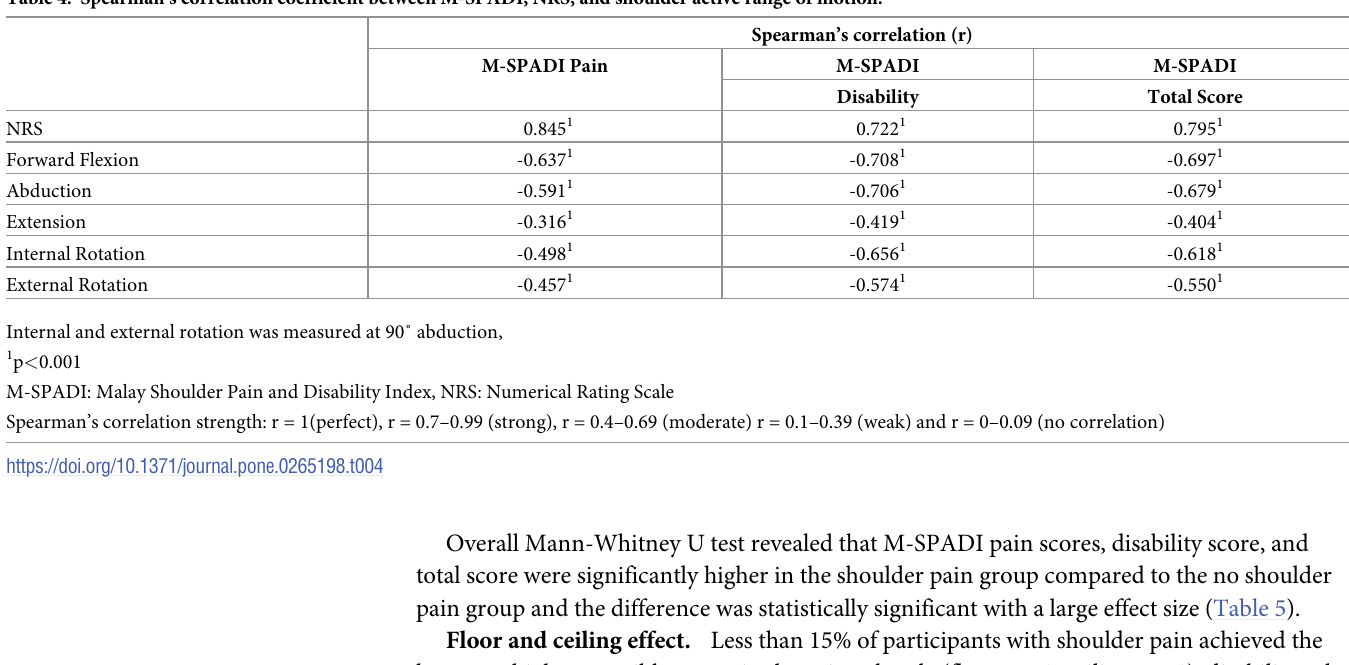
total score were significantly higher in the shoulder pain group compared to the no shoulder pain group and the difference was statistically significant with a large effect size (Table 5). Floor and ceiling effect. Less than 15% of participants with shoulder pain achieved the